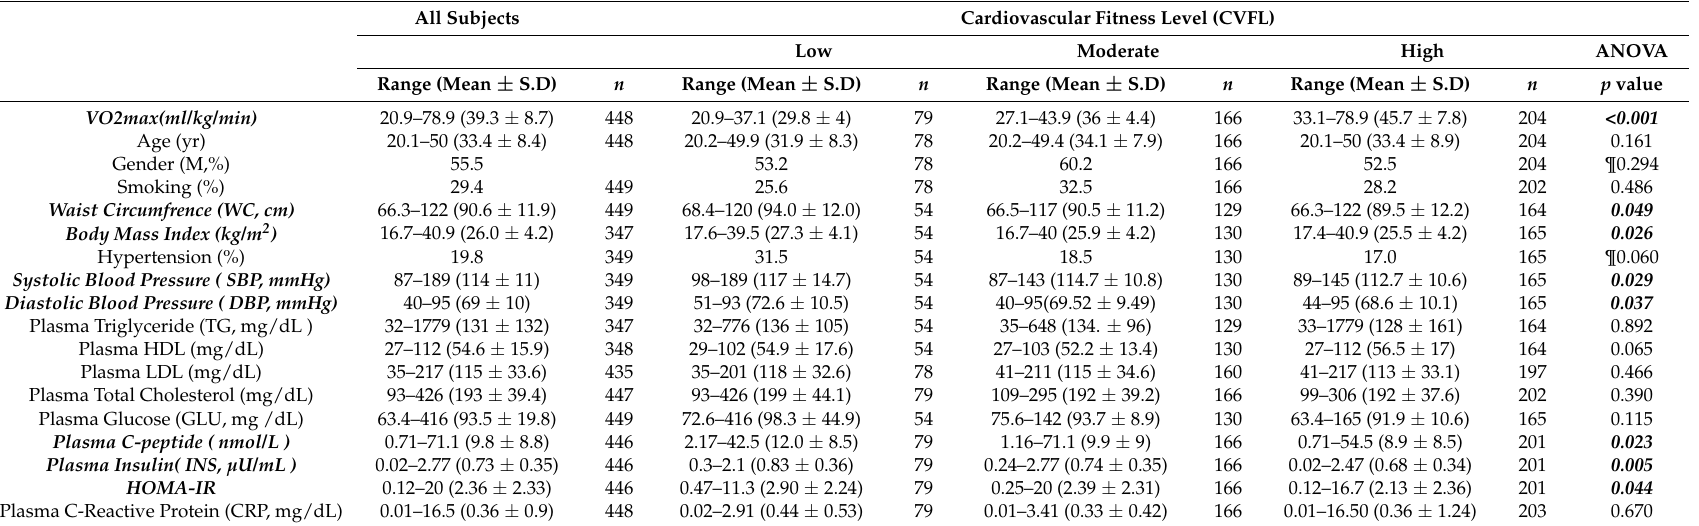
Table 1. Demographic characteristics of the study population: overall and stratified by cardiovascular fitness levels. CVFLs were categorized into Low, Moderate, and High by estimated VO2max with gender and age specific percentile. Significant values are shown in bold and italic